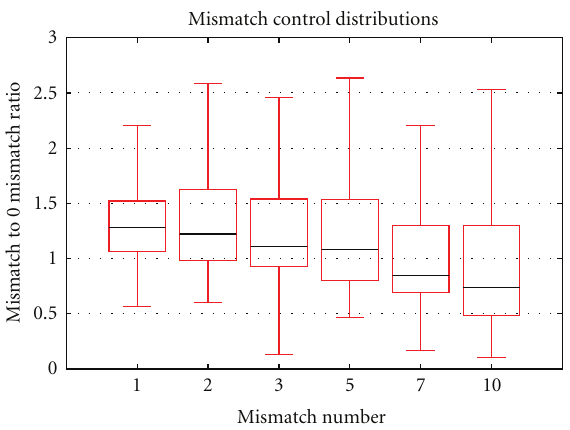
Figure 5: Di ff erential signal detection from mismatch-target oligonucleotides on the BOM array. The normalized signal intensity from target oligonucleotides with 1, 2, 3, 5, 7, and 10 mismatches are presented as a percentage of the log intensity for their respective perfect match target oligonucleotides. The minimum and maximum values for each number of mismatches (vertical lines), the first and third quartiles (white boxes which contain 50% of the values), and the median (black line) are